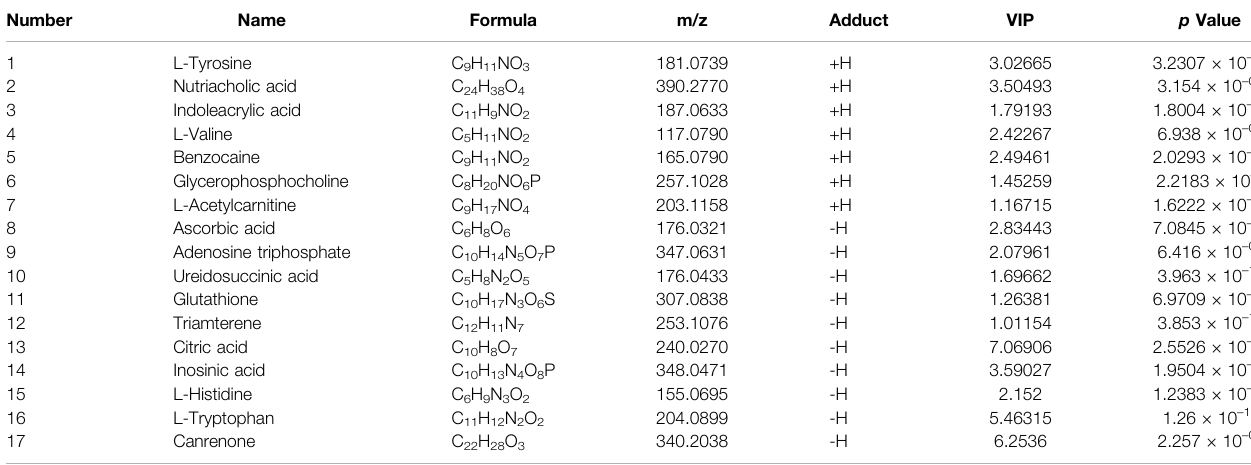
TABLE 2 | Potential differential metabolites induced by barium chloride in zebra fi sh